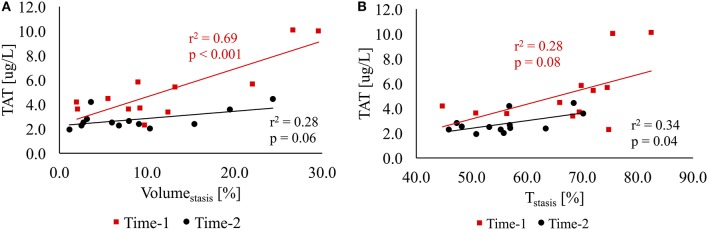
(A) The linear regression analysis between TAT and volume of stasis (Volumestasis) as a percentage of the LA volume at Time-1 (red) and Time-2 (black). (B) The linear regression analysis between TAT and duration of stasis (Tstasis) as a percentage of the cardiac cycle at Time-1 (red) and Time-2 (black).